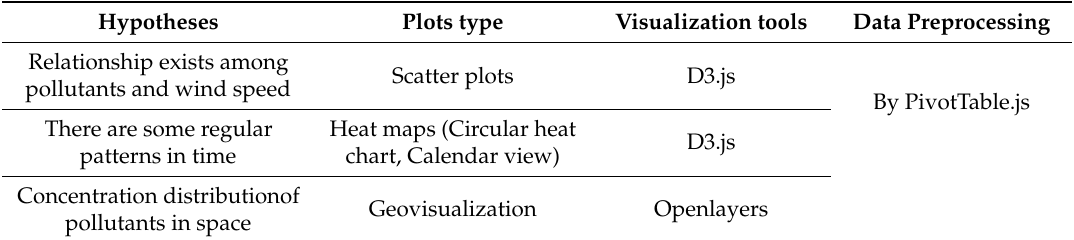
Table A2. Hypothesis and visualization project design for